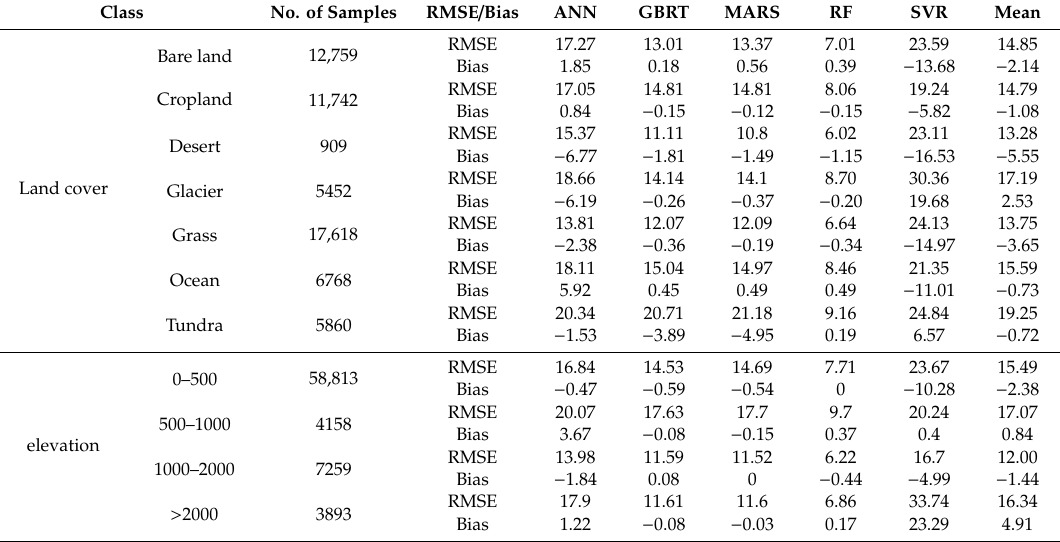
Table 3. Averaged RMSE and bias (W m − 2 ) of sites with same land cover type or elevation on the training dataset.